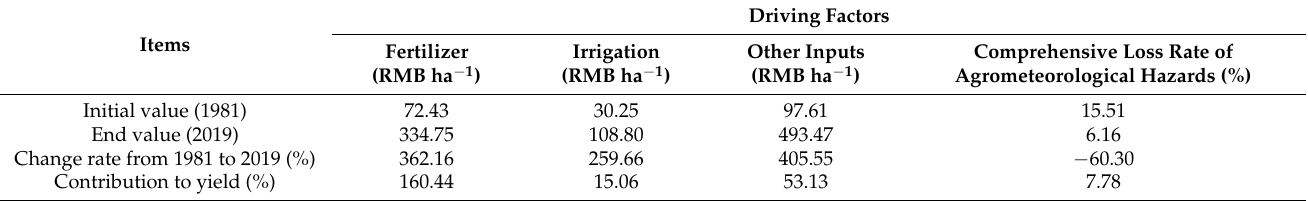
Table 4. Driving factors for the yield of the main staple grain of Inner Mongolia Autonomous Region from 1980 to